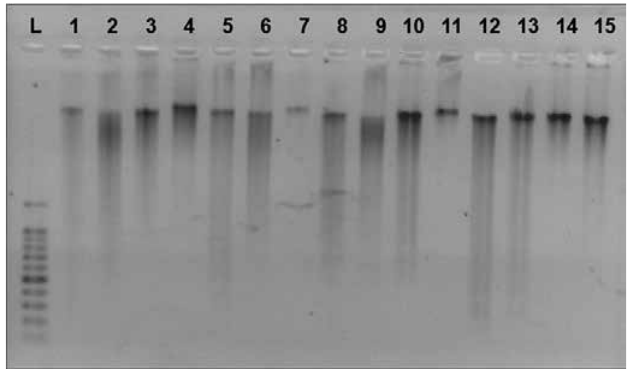
figurE 1 – Agarose gel (1%) stained with blue green loading dye showing gel electrophoretic profile for DNA